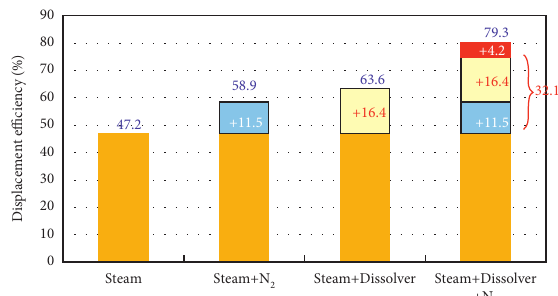
Figure 6: Schematic diagram of thermochemical combined flooding.